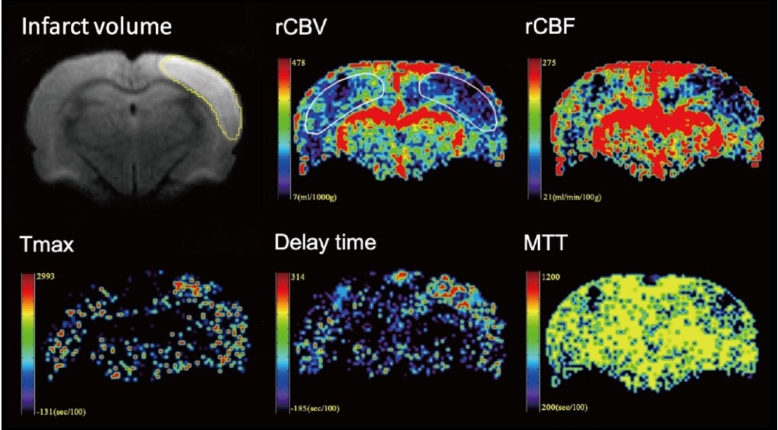
Figure 2. Representative images from one rat of the control group. The volume of the infarction was manually measured on the diffusion-weighted imaging (DWI) map. To measure the perfusion indices, the region of interest (ROI) was manual drawing in the infarcted hemisphere on the relative cerebral blood volume (rCBV) image. A mirror ROI on the contralateral healthy hemisphere was then generated automatically by the software. The ROIs were applied to other perfusion maps to measure other perfusion indices.